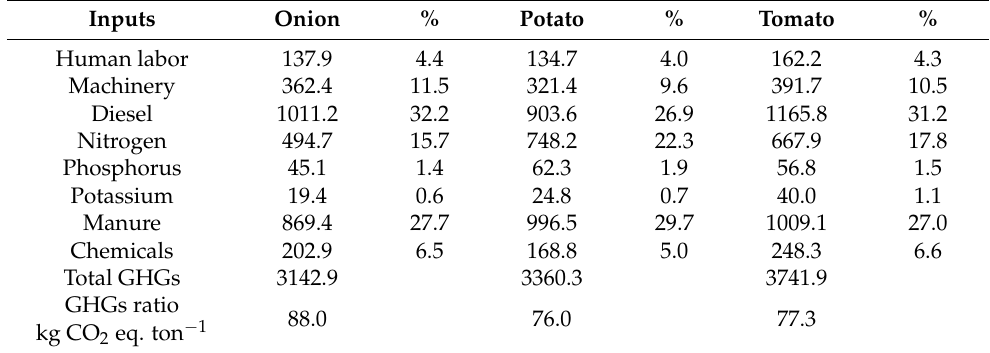
Table 4. The amount of GHG (kg CO 2 eq. ha − 1 ) emissions concerning production